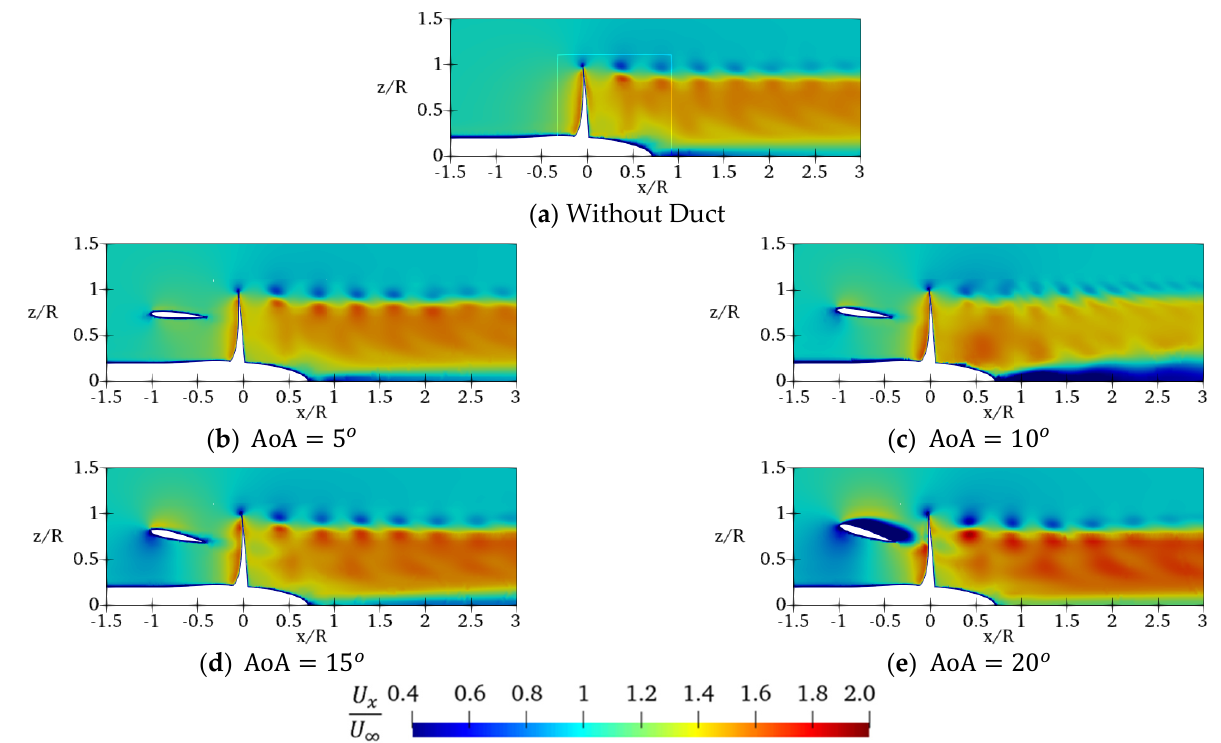
Figure 5. Instantaneous non-dimensional axial velocity contours on longitudinal plane for small duct ( D D = 0.7 D P ).